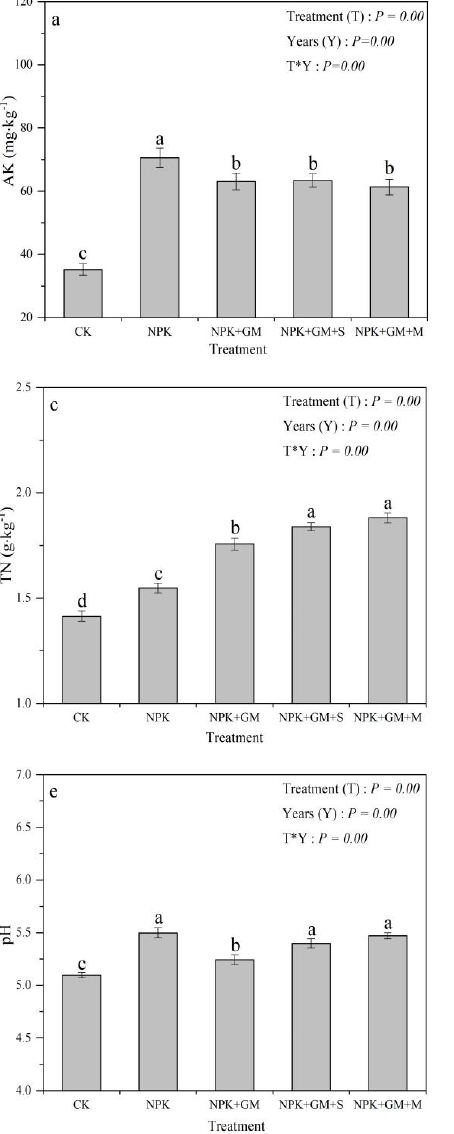
Figure 3. Effects of different treatments on the soil factors influencing the rice yield. The subfigure ( a – e ) represent the order of soil AK, SOC, TN, TP, pH, respectively. Different letters ( a – c ) indicates significant differences ( p < 0.05) between